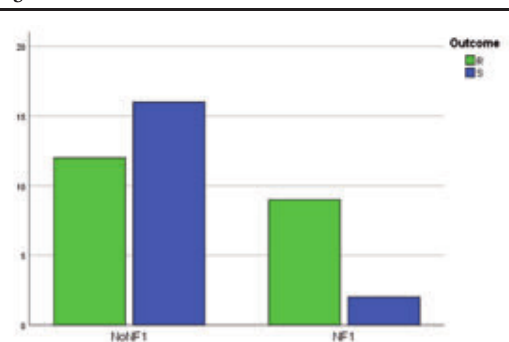
RISULTATI: L’analisi delle RMN encefalo di fine indu- zione e consolidamento ha consentito di individuare i pazienti con riduzione di malattia (diminuzione delle dimensioni tumorali >20%) e con stabilità di malattia.